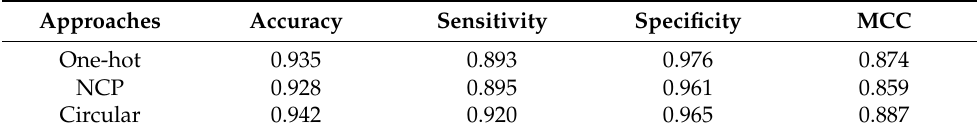
Table 6. Comparison of different encoding schemes using M. musculus species.